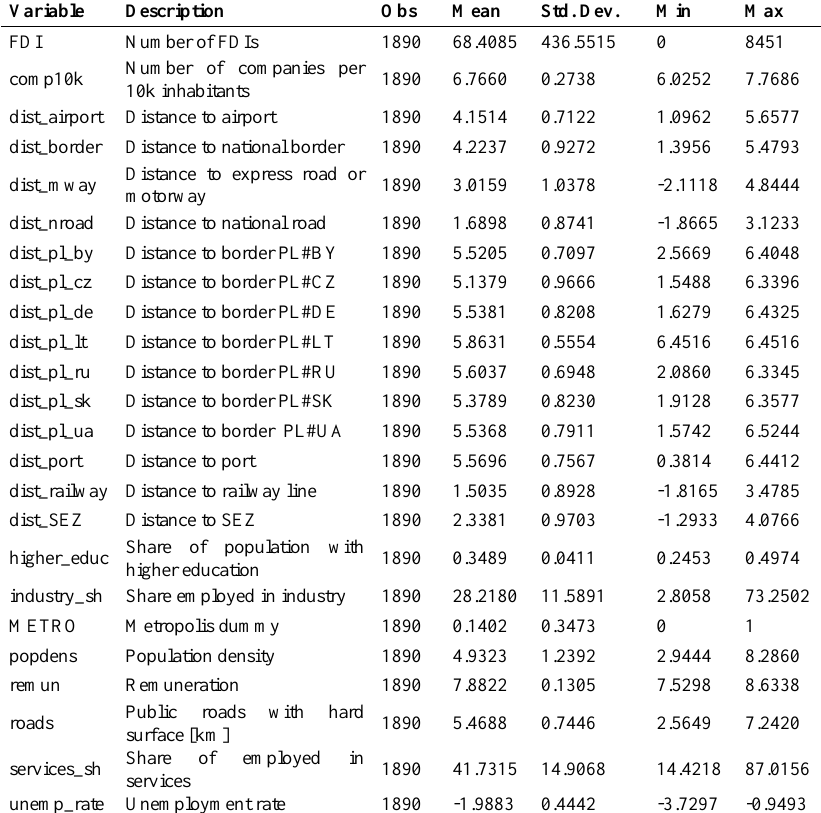
Table 2. Descriptive